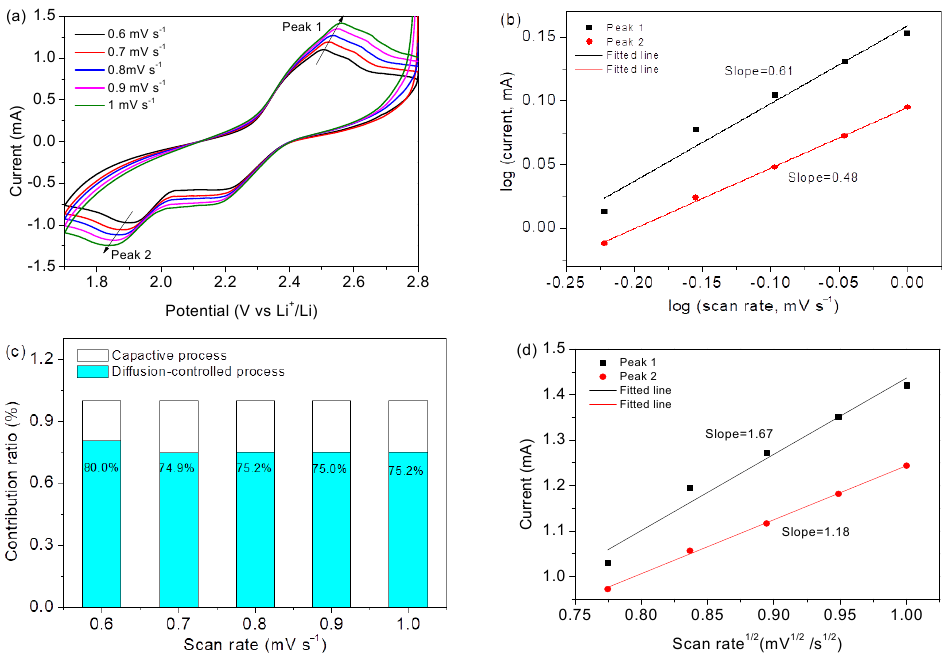
Figure 9. ( a ) CV profiles of the Co 3 O 4 /S-infilled microcapsules. ( b ) Relationship of log( v ) vs log( i ). ( c ) Contribution ratios. ( d ) Relationship of peak current vs. rate.